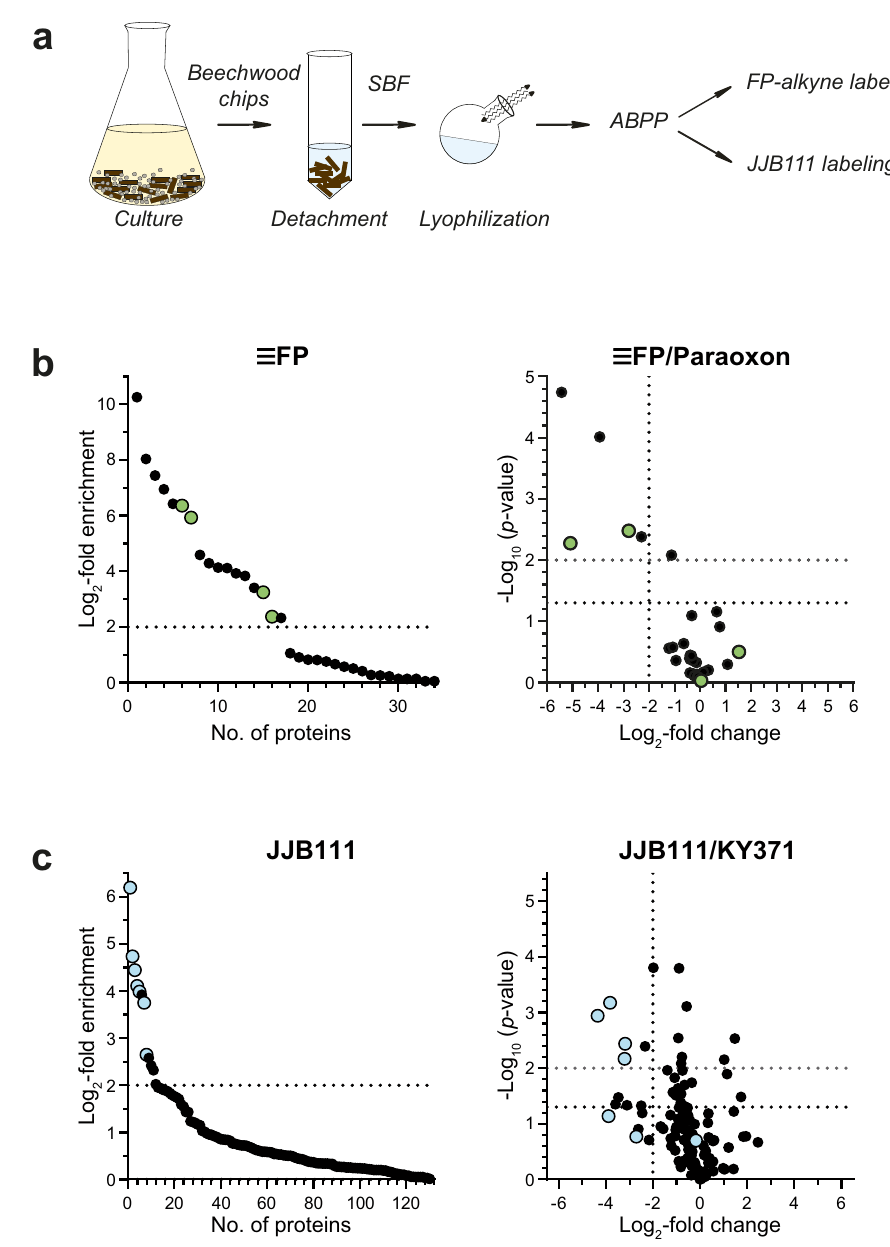
Fig. 3 ABPP of P. chrysosporium substrate-bound fraction (SBF). a Work fl ow of the SBF analysis. P. chrysosporium suspension cultures were grown for 5 days on a minimal medium supplemented with beech wood chips. The beech wood chips were isolated and substrate-bound proteins were isolated via 0.1% (w/v) dodecylmaltoside treatment. The obtained protein solution was lyophilized and the residue was subjected to ABPP with the corresponding probes. b ABPP of SHs without (left panel, log 2 -fold change ≥ 2 compared to DMSO is indicated) or after pretreatment with 50 µ M paraoxon (competition experiment, right panel) and 2 µ M FP-alkyne after click chemistry ( n = 4 biologically independent samples). Green dots indicate annotated CEs. c ABPP of GHs without (left panel, log 2 -fold change ≥ 2 compared to DMSO is indicated) or after pretreatment with 20 µ M KY371 (competition experiment, right panel) with 2 µ M JJB111 ( n = 3 biologically independent samples). Blue dots indicate annotated